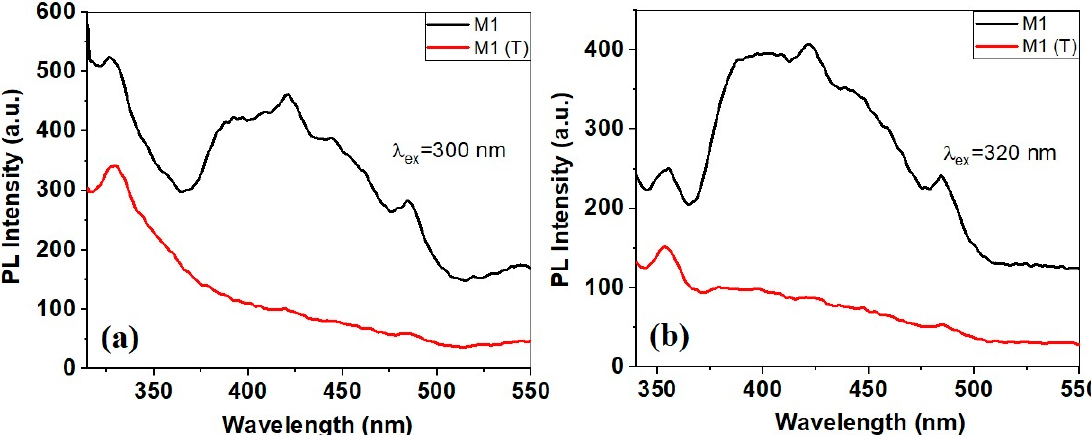
Figure 7. Photoluminescence spectra of CAB / ZnO and Carbon / ZnO nanostructures as a function of excitation wavelength 300 ( a ), and 320 nm ( b ).